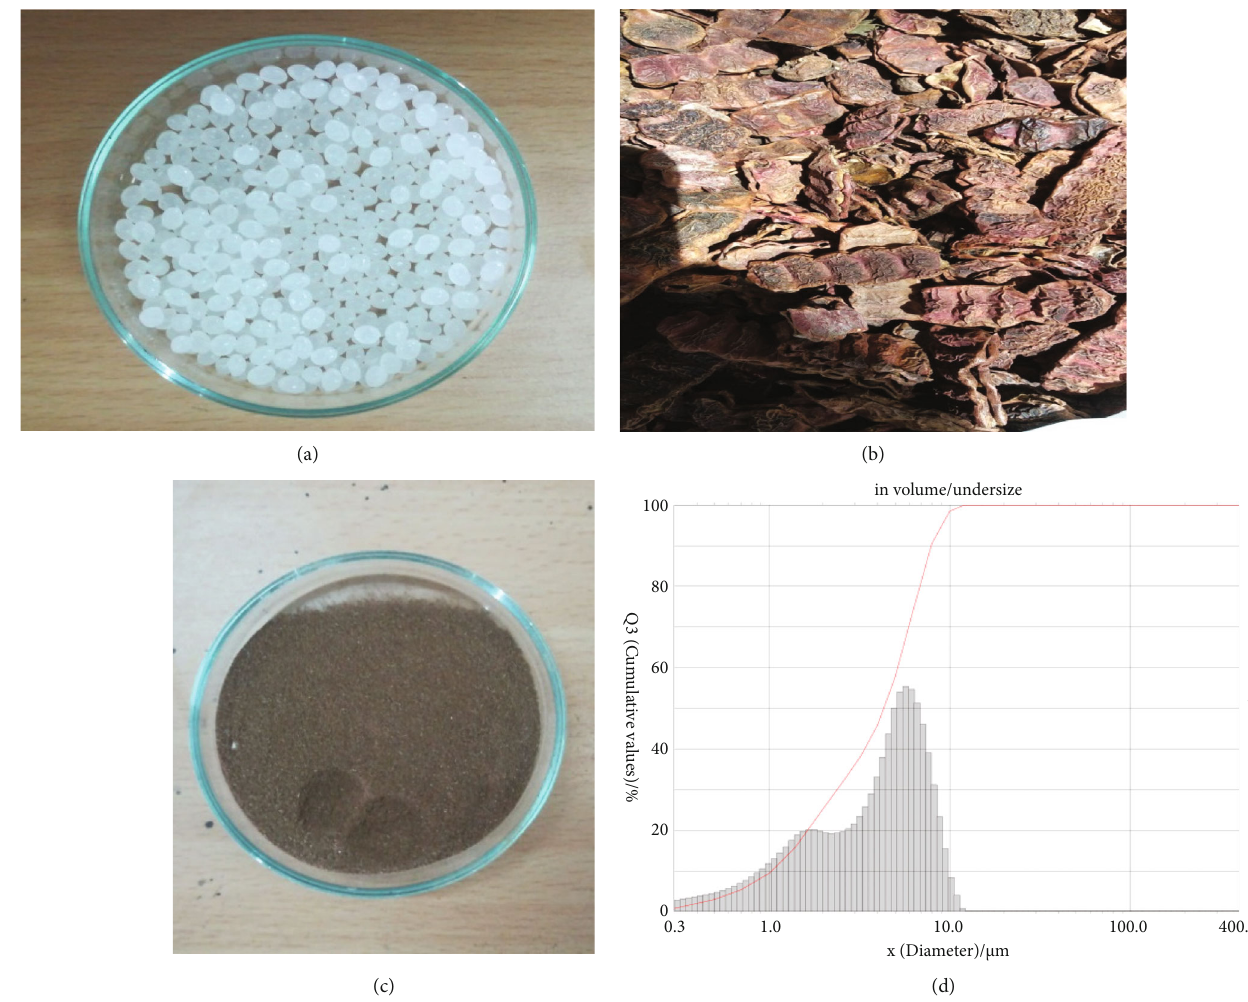
Figure 1: (a) PLA granules, (b) A. concinna (AC), (c) pulverized ACF, and (d) particle size of the ACFs.